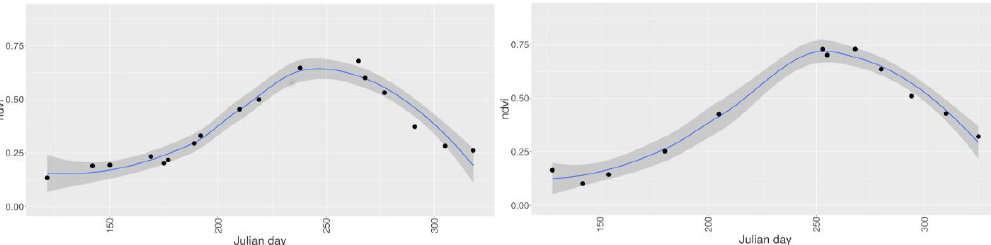
Figure 8 . Temporal progression of NDVI (average (blue line) and standard deviation (shaded)) for all the fields for a specific crop (cumulative statistics) based on all the VHSR satellite images processed in the workflow. Statistics for all peanut fields in Sukumba, Mali, for the year 2014 ( left ) and for all maize fields in Kofa, Nigeria, for the year 2015 ( right ).